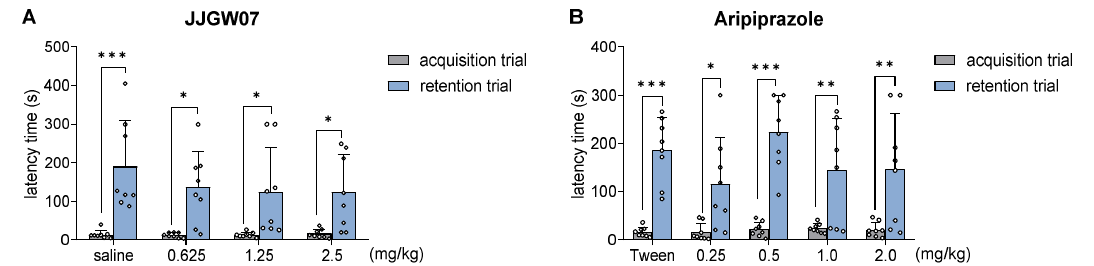
Figure 4. The influence of JJGW07 (Panel ( A )) and aripiprazole (panel ( B )) on the latency in the step-through passive avoidance task in mice. The experiment consisted of two sessions. In the acquisition trial, mice were placed individually in the light chamber of the apparatus, with the door opening after 30 s. When the animal crossed to the dark chamber, the door closed and the animal was punished with an electric shock (0.8 mA, 2 s). JJGW07 and aripiprazole were administered intraperitoneally ( ip ) 30 min before the start of the experiment. The control group received an ip 0.9% NaCl solution or 1% Tween. On the second day of the test, the mice were placed again in a bright chamber and the latency was measured for a maximum of 300 s (without the electrical impulse). Values are expressed as means ± SD; n = 8 mice per group. Statistical analysis: two-way ANOVA with repeated measures (Bonferroni post hoc); * p < 0.05, ** p < 0.01, *** p < 0.001 vs . acquisition trial. Aripiprazole, used as a reference compound at the doses of 0.25–2.0 mg/kg, did not influence the latency time in the acquisition trial, whereas it significantly increased the latency time in the retention trial at all tested doses compared to the acquisition session. The statistical analysis showed a significant time effect (F(1,35) = 91.76, p < 0.0001), but no influence of the compound (F(4,35) = 1.627, p = 0.189) and no interaction (F(4,35) = 1.538, p